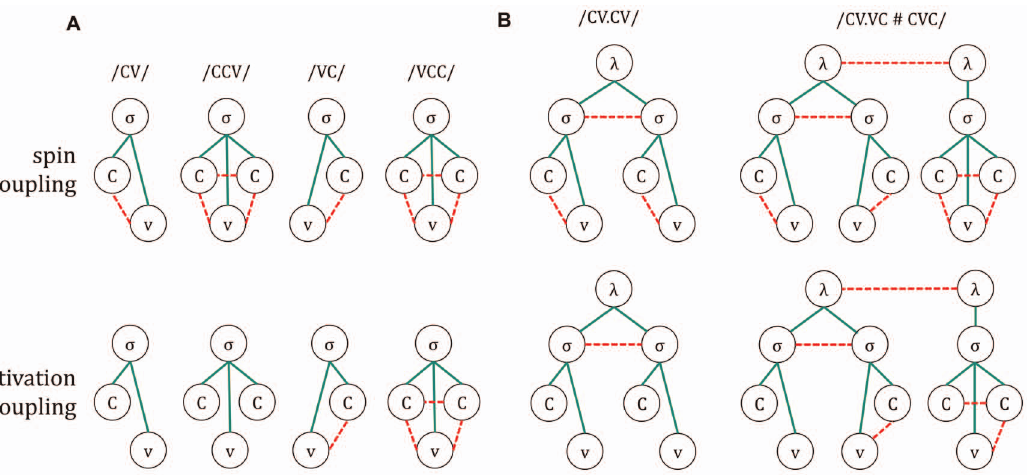
Figure 6. Examples of activation and spin coupling graphs. Attractive/excitatory coupling relations solid lines) and repulsive/inhibitory coupling relations (dashed lines) are shown. (A) monosyllables; (B) multisyllabic and multi-word responses.